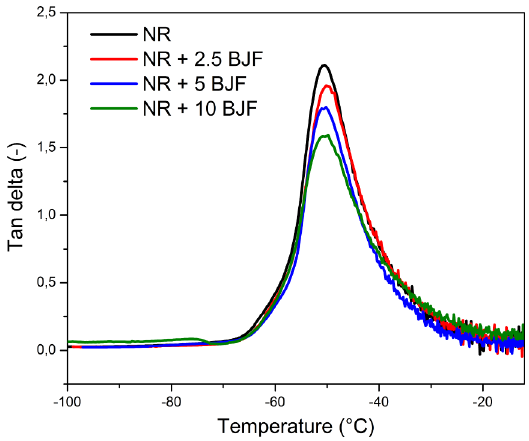
Figure 4. Tan delta versus temperature for NR